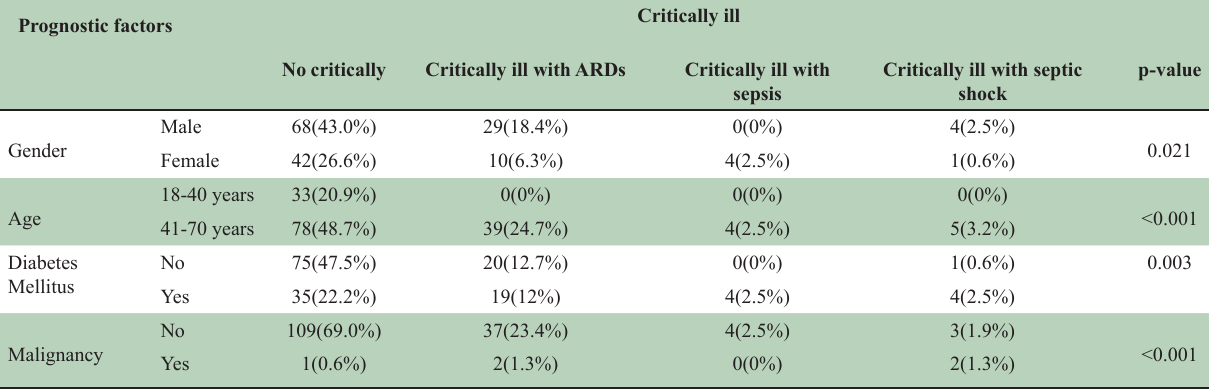
Table-IV: Association of prognostic indicators and critically ill